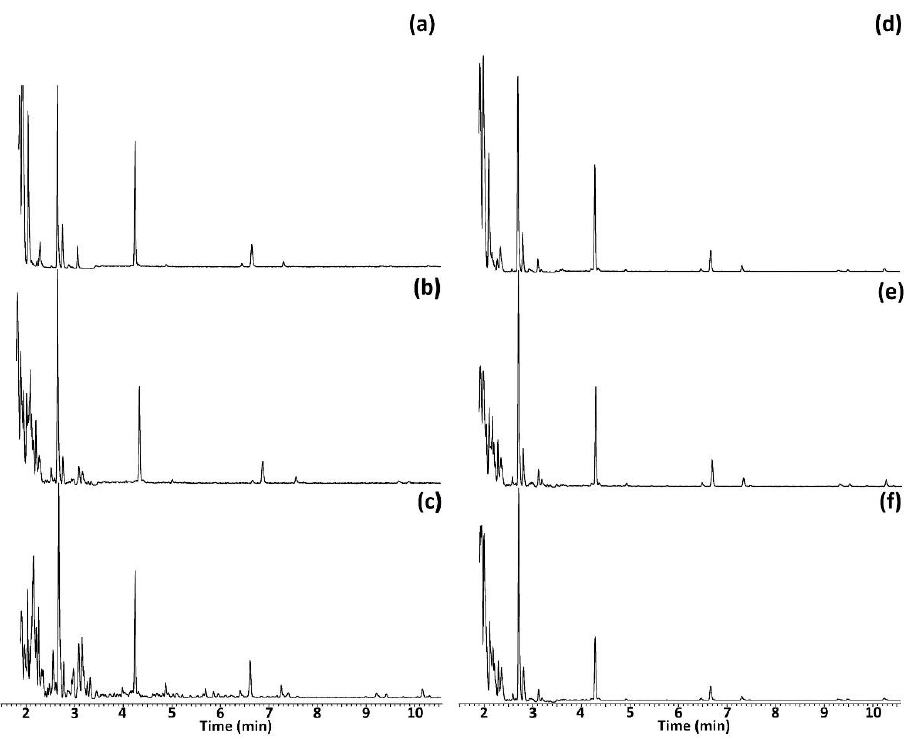
Figure 7. GC-MS chromatograms of impinger trapped products from the catalytic pyrolysis of BMP at ( a ) 500 °C, ( b ) 550 °C, and ( c ) 600 °C and CMP at ( d ) 500 °C, ( e ) 550 °C, and ( f ) 600 °C.